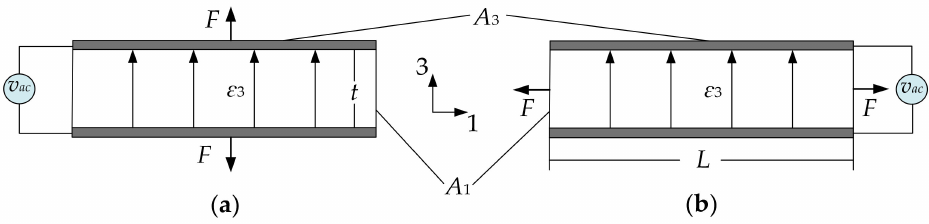
Figure 21. Piezoelectric transduction configuration. ( a ) Longitudinal configuration; ( b ) Transverse configuration. Note: t is the thickness of the piezoelectric layer, A 1 is the cross-sectional area of the piezoelectric layer, A 3 is the electrode area, ε 3 is the intensity of the electric field, and F is the generated force.